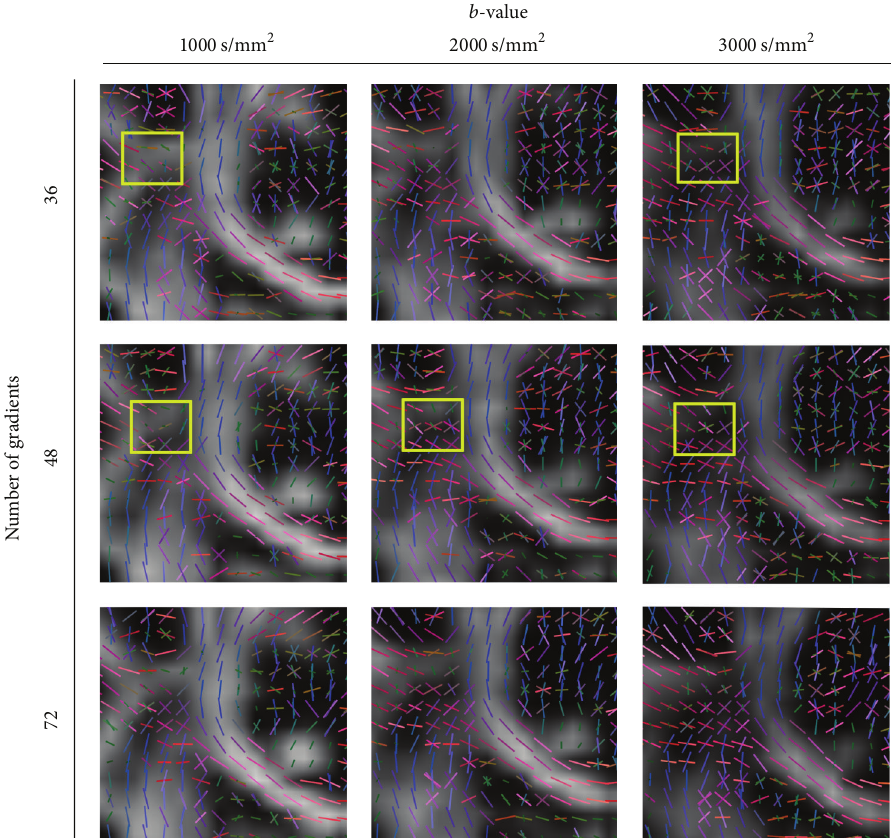
Figure 7: The effect of the 𝑏 -value and the number of gradients at ℓ = 6 . We observe that the crossings from CC and CR are already observed in the lowest parameter combination of 𝑏 = 1000 s / mm 2 and NG = 36 . The SLF structures become more prominent at higher 𝑏 ≥ 2000 s / mm 2 (see yellow marked